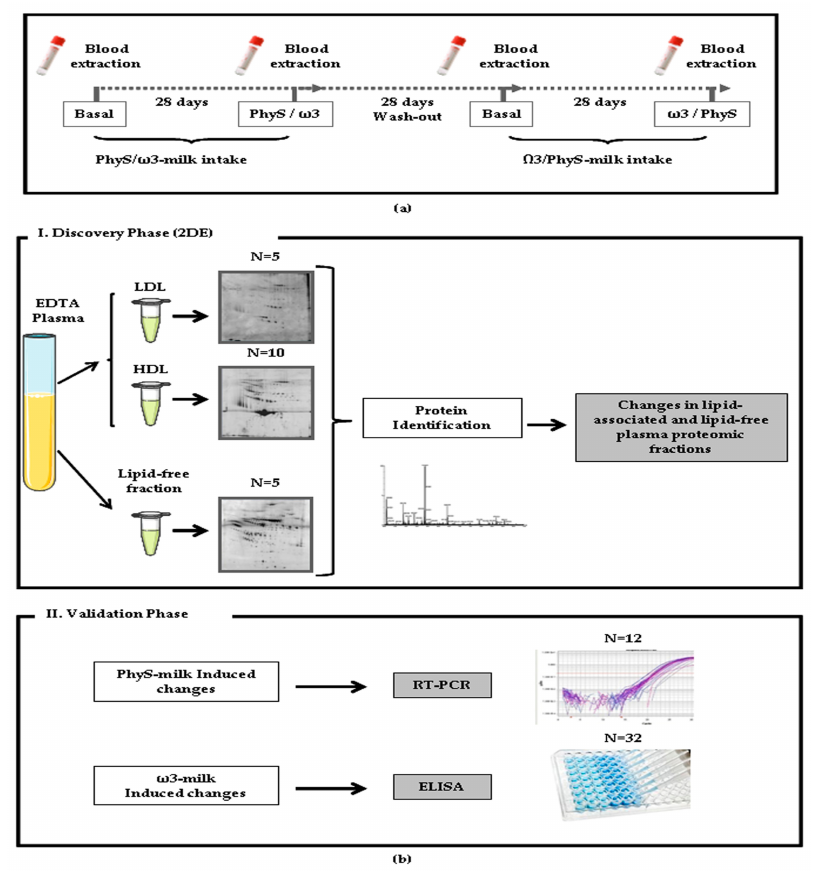
Figure 1. Study design. ( a ) Blood samples were obtained before and after the 28 day milk supplementation treatment period. A 28 day wash-out was made between treatments; ( b ) The study workflow of the present study comprised two phases: ( I ) the discovery phase in which a proteomic approach was used to identify changes in the proteomic profile of the different plasma fractions after the intake of supplemented milk ( N = 5); and ( II ) the validation phase, where different selected proteins were validated by ELISA ( N = 32) and inflammatory changes were analyzed by reverse transcription polymerase chain reaction (RT-PCR; N =